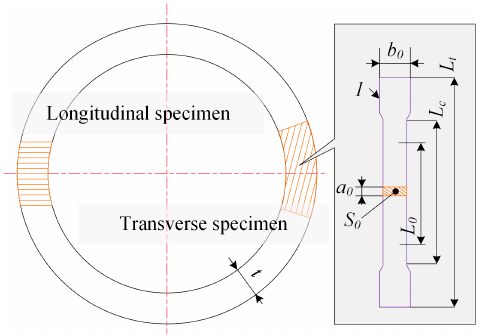
Figure 2. Sampling